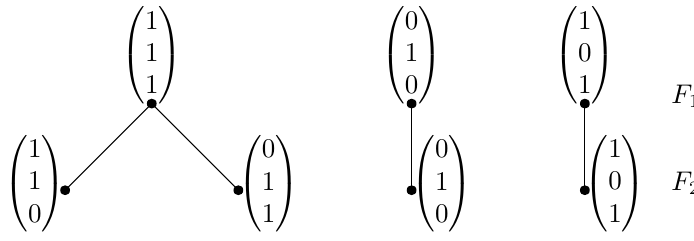
Figure 4. Subtree of F with assigned result vectors for each node.